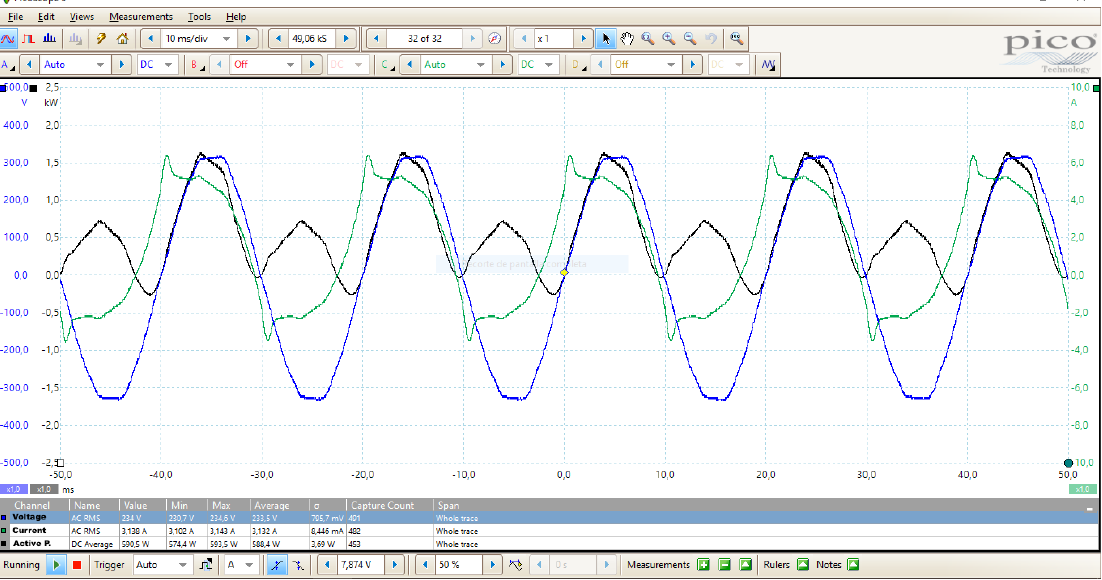
Figure 19. Non-linear load analysis with Picotech